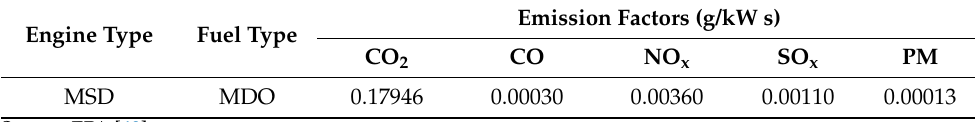
Table 7. Auxiliary engine power ratios and load factor in port during hoteling mode.